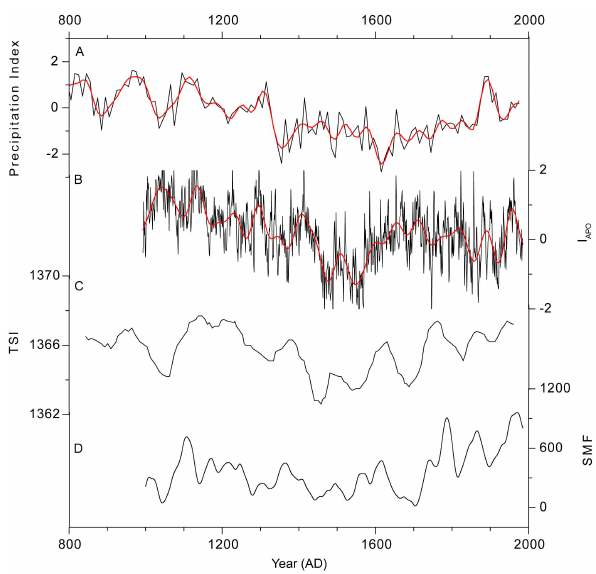
Fig. 6. Comparison of the precipitation variations in north cen- tral China, the Asian Pacific Oscillation, and the solar activity. Panel (A) is the synthesized precipitation index record. Panel (B) is the Asian Pacific Oscillation index record (Zhou et al., 2009). Panel (C) is the reconstructed total solar irradiance (TSI) record (Bard et al., 2000). Panel (D) is the reconstructed solar modulation function (SMF) record (Muscheler et al., 2007). The red lines in panels (A) and (B) are records after 50-year low pass FFT